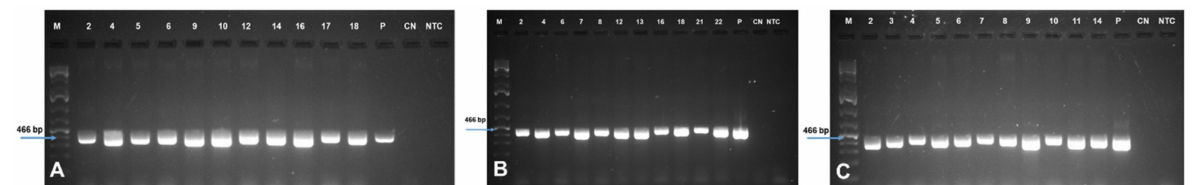
Figure 4. PCR amplification using AChE specific primers to show the presence of transgene in the transgenic banana and plantain events: ( A ) Cavendish Williams, ( B ) Orishele, ( C ) Gonja Manjaya. M—molecular marker 1 kb ladder; NTC— nontemplate control; CN—control nontransgenic plant; +—plasmid as positive control, numbers on lanes of the image ( A – C ) indicate the independent transgenic events of Cavendish Williams, Orishele, and Gonja Manjaya, respectively.